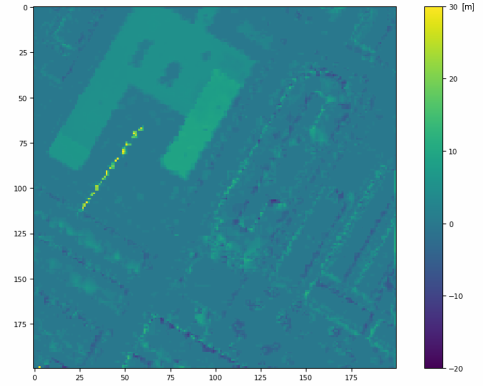
Figure 3. 3D change detection map obtained through difference of the DSMs. The colour bar is expressed in meters only the pixels affected by a real change in elevation were con- sidered, while the pixels in which no real change had occurred, and thus containing only noise, were set equal to zero. An ex- ample can be observed in Figure 4. A further check was carried out to assess the absence of coregistration errors, both in the orthophotos and in the DSMs.